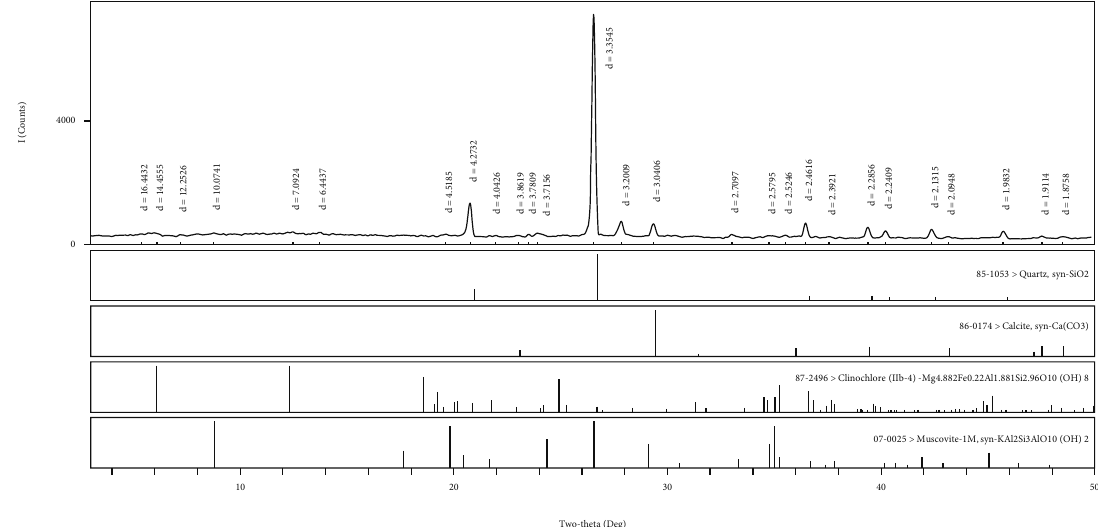
Figure 1: XRD analysis of argillaceous siltstone material in this